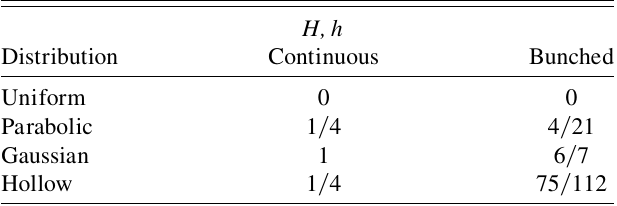
TABLE I. Halo parameter values for some common analytic